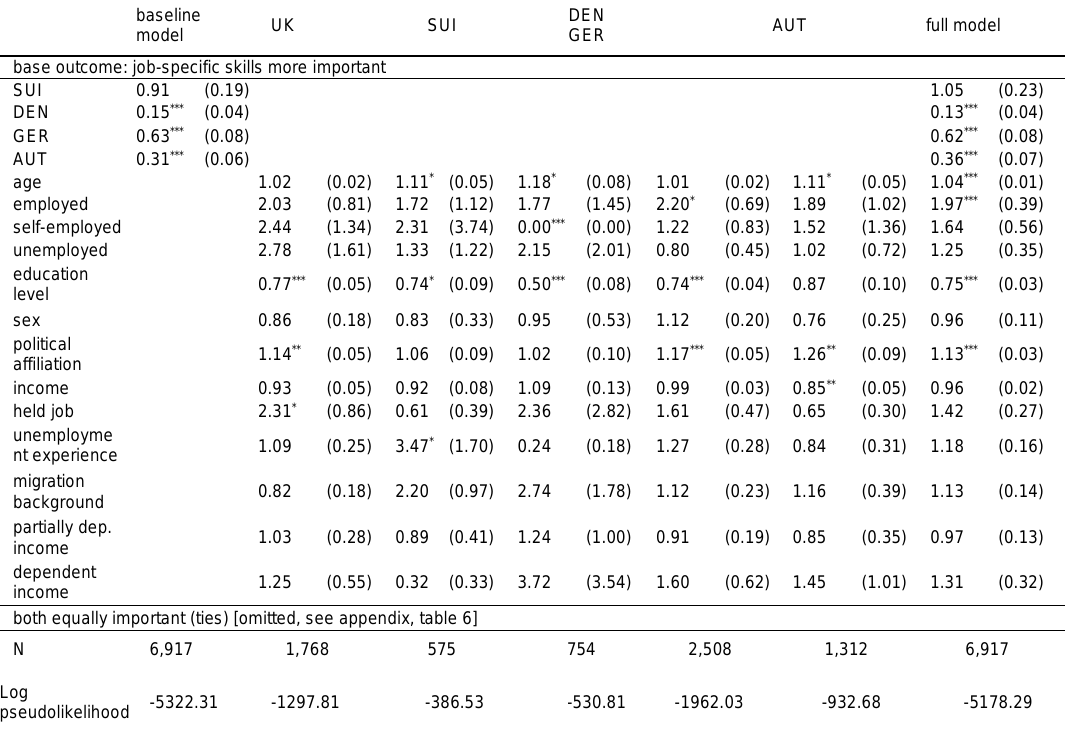
Table 6. Multinomial logistic models for the comparison of willingness to retrain vs. willingness to learn new